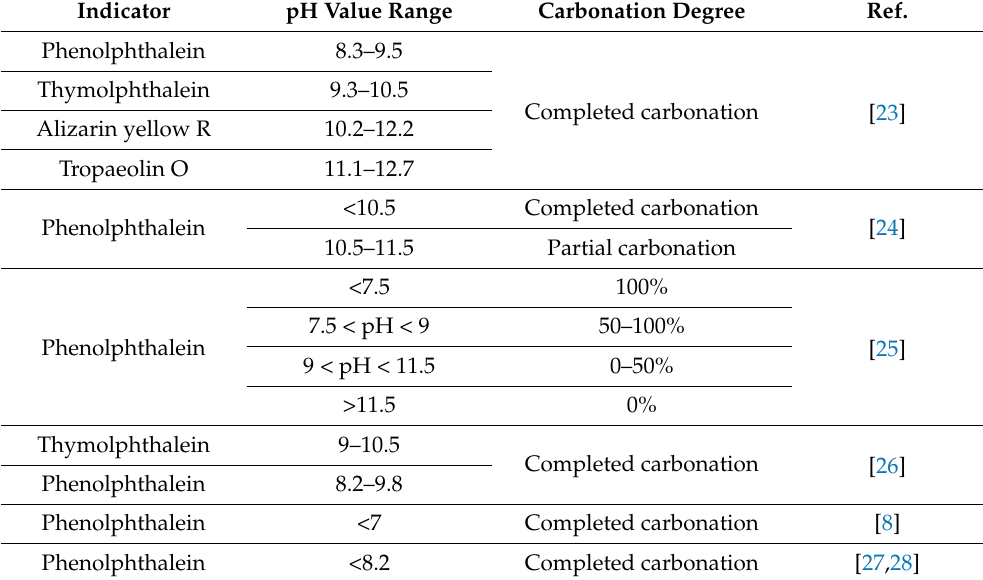
Table 1. Summary of the experimental investigations on different pH scale range and carbonation degree depending on type of